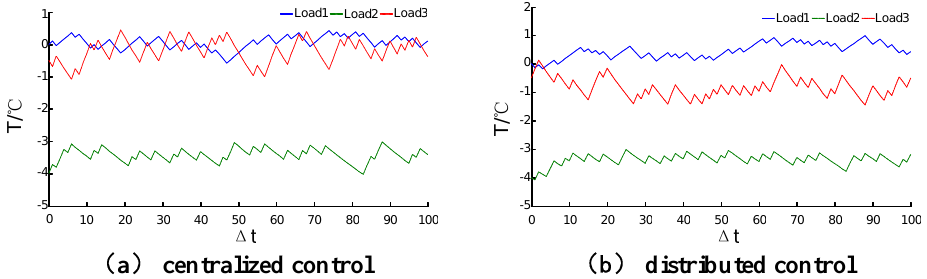
Figure 14. The function indexes comparison of centralized and distributed control; ( a ) centralized control; ( b ) distributed control.